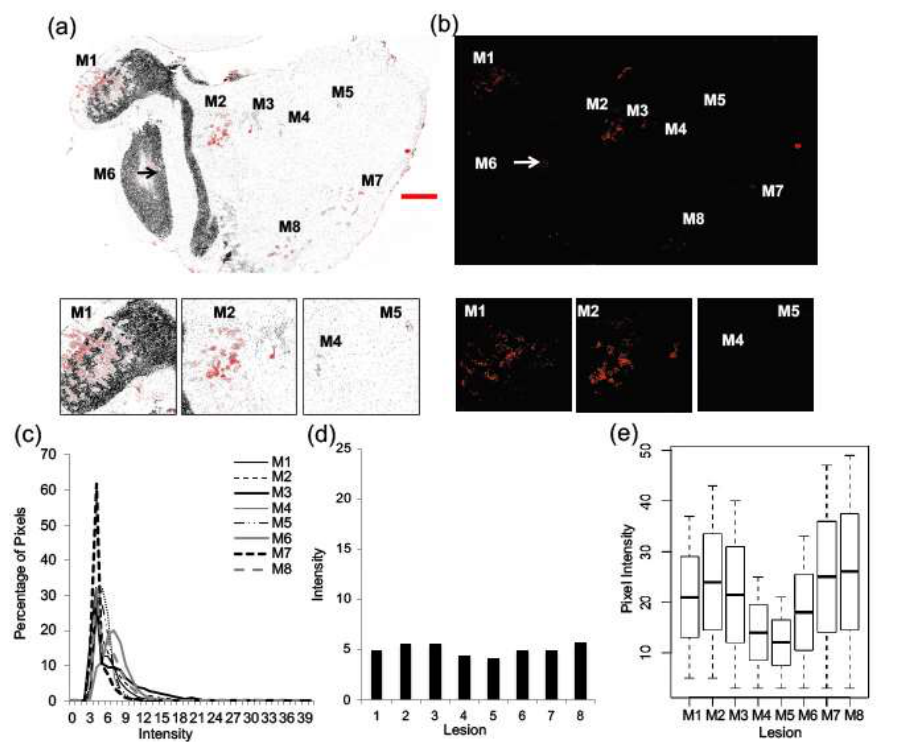
Figure 6. Inter-metastatic heterogeneity is not observed in Her2/neu expression across brain lesions. Tissue sections of the brain were probed for Her2/neu expression and imaged for Her2/neu (red) and Hoechst (grey) ( n = 2). A representative image of a section of brain tissue is shown ( a ), and metastatic lesions are identified as M1 through to M8. Selected lesions from the brain are also shown (M1, M2, M4, and M5). A heat map was generated from the greyscale image of Her2/neu fluorescence ( b ). Her2/neu expression was examined by looking at the distribution of pixels across intensity levels from 0 to 255 for each lesion within the tissue ( c ). The average pixel intensity for each lesion was also plotted ( d ). Boxplots were used to illustrate the distribution of pixels across intensity levels for each lesion within one brain section, and a Kruskal–Wallis test provided a statistically significant p -value (<0.005) ( e ).